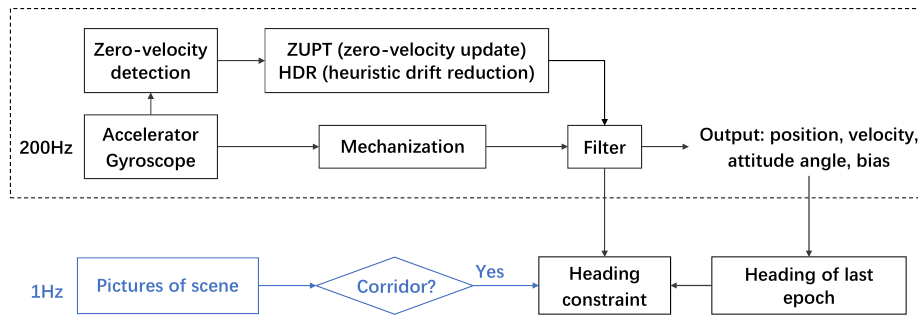
Figure 1. Main blocks in the inertial navigation algorithm based on scene